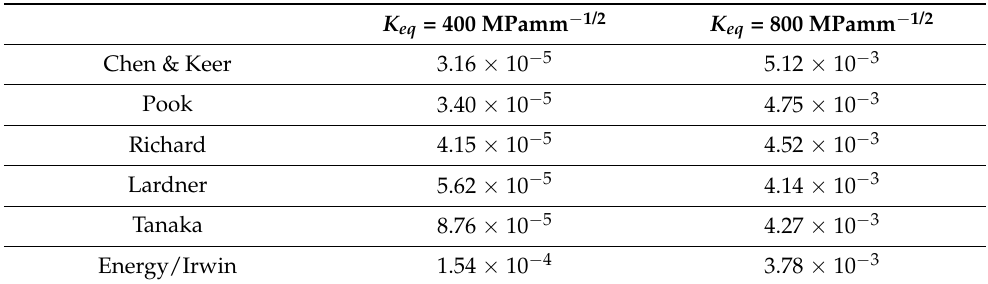
Table 2. FCG rate for 6082 T6 for K eq = 400 MPamm − 1/2 and for K eq = 800 MPamm − 1/2